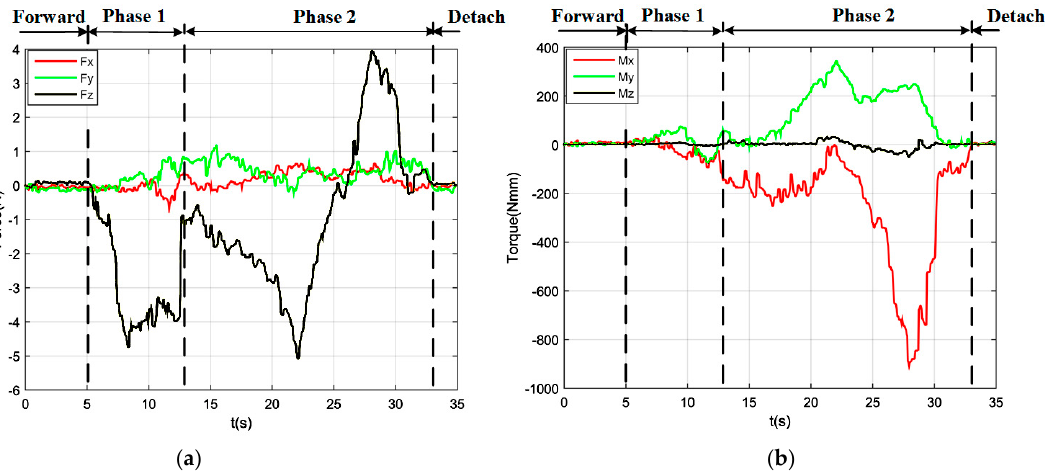
Figure 16. Round pieces: interaction forces and torques toward dual-arm operation (Phase 1: outside adjustment phase; Phase 2: inside adjustment phase). ( a ) Interaction forces; ( b ) interaction torques.